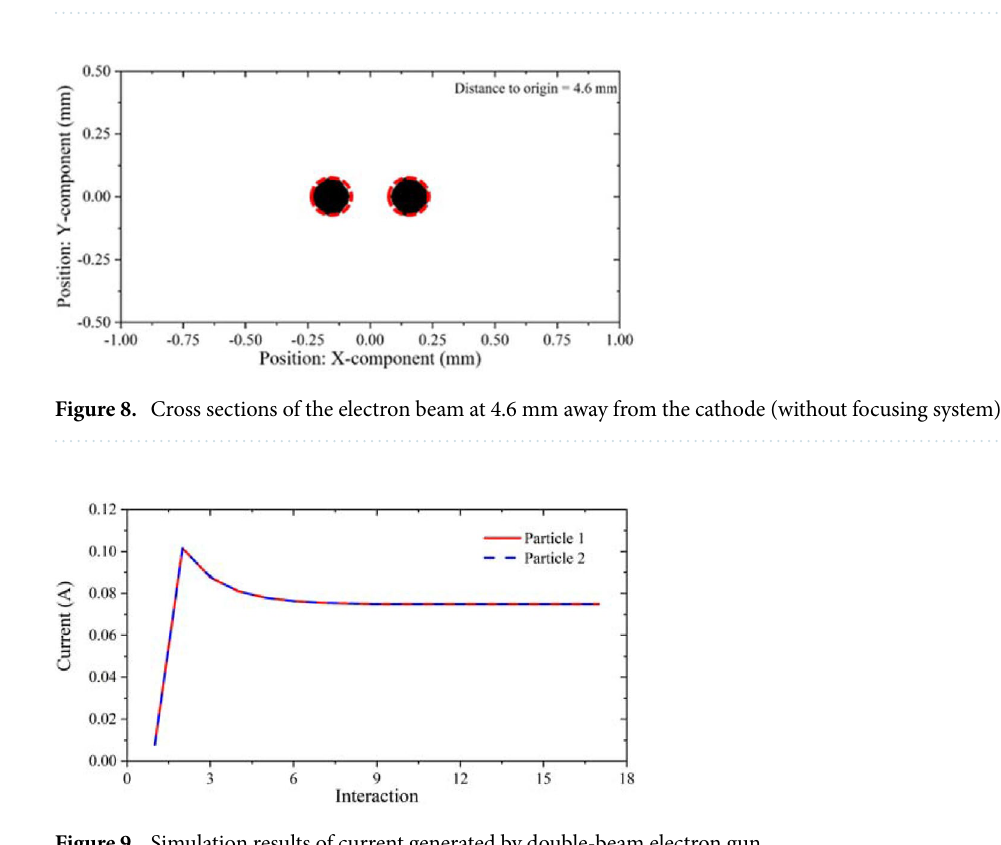
Figure 7. Beam envelopes of the double-beam gun in x and y directions.